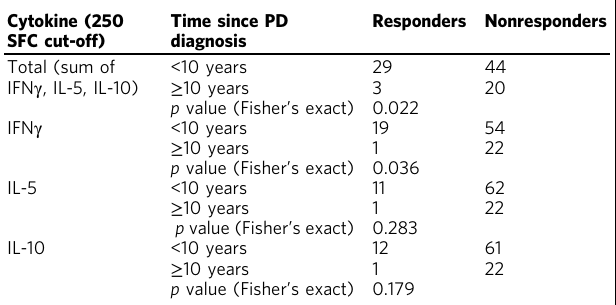
Table 1 Number of responders and nonresponders at 250 SFC and 10-year diagnosis